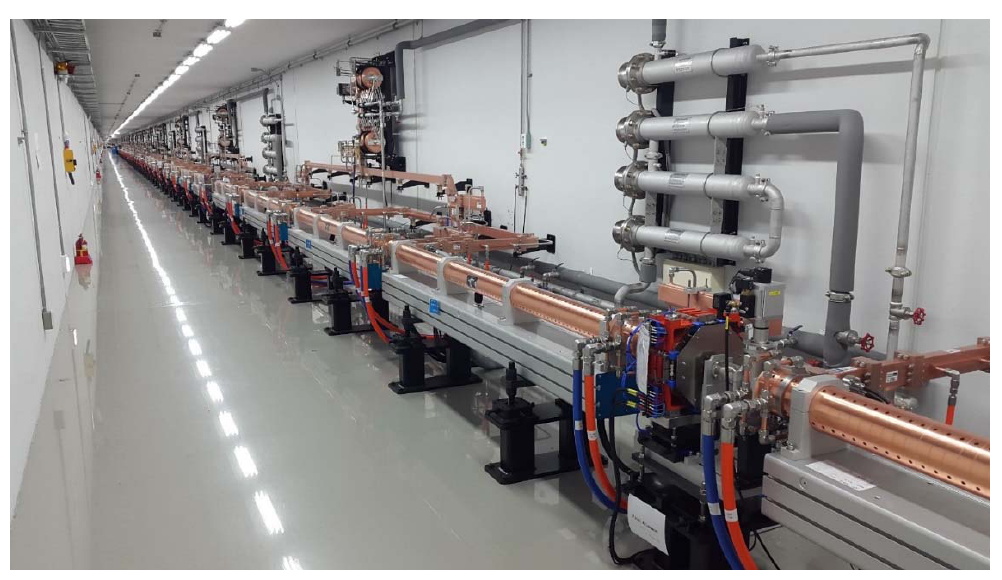
Figure 3. LINAC tunnel of PAL ‐ XFEL.